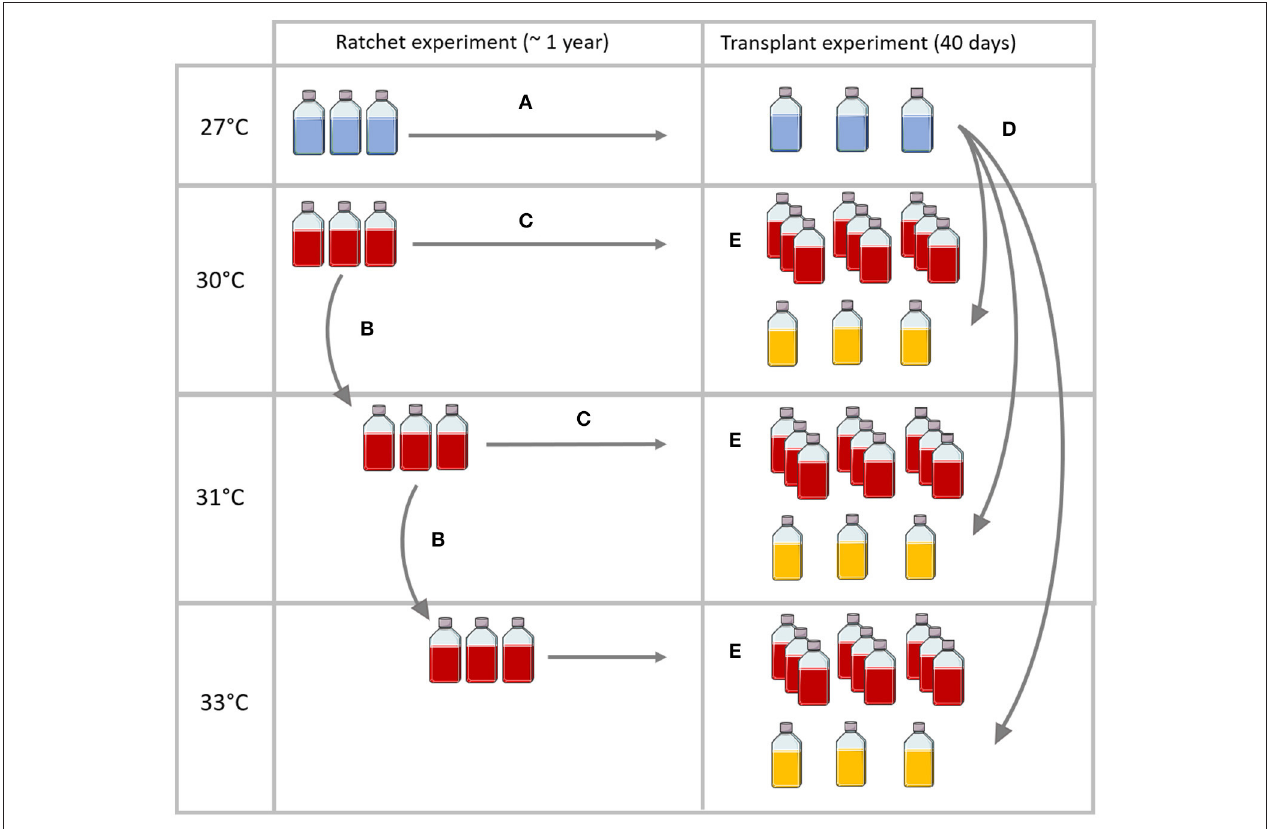
FIGURE 1 | Simplified experimental design to show long-term thermal selection (ratchet experiment) ending in an acute heat stress transplantation experiment. (A) Control replicate cultures were kept at 27 ◦ C throughout the duration of the long-term selection experiment. (B) Replicate populations were moved to the next, elevated temperature treatment if after six weeks they exhibited positive growth. (C) For populations that were eligible to be transferred to the next temperature treatment, an aliquot was also kept at the same temperature conditions throughout the experiment. (D) After one year, control replicate cultures were transferred to each of the elevated temperature treatments that the temperature-selected populations had achieved (E) after one year of thermal selection, thermally selected populations were split into three replicate cultures and maintained in their own temperature conditions. A 40-day transplant experiment